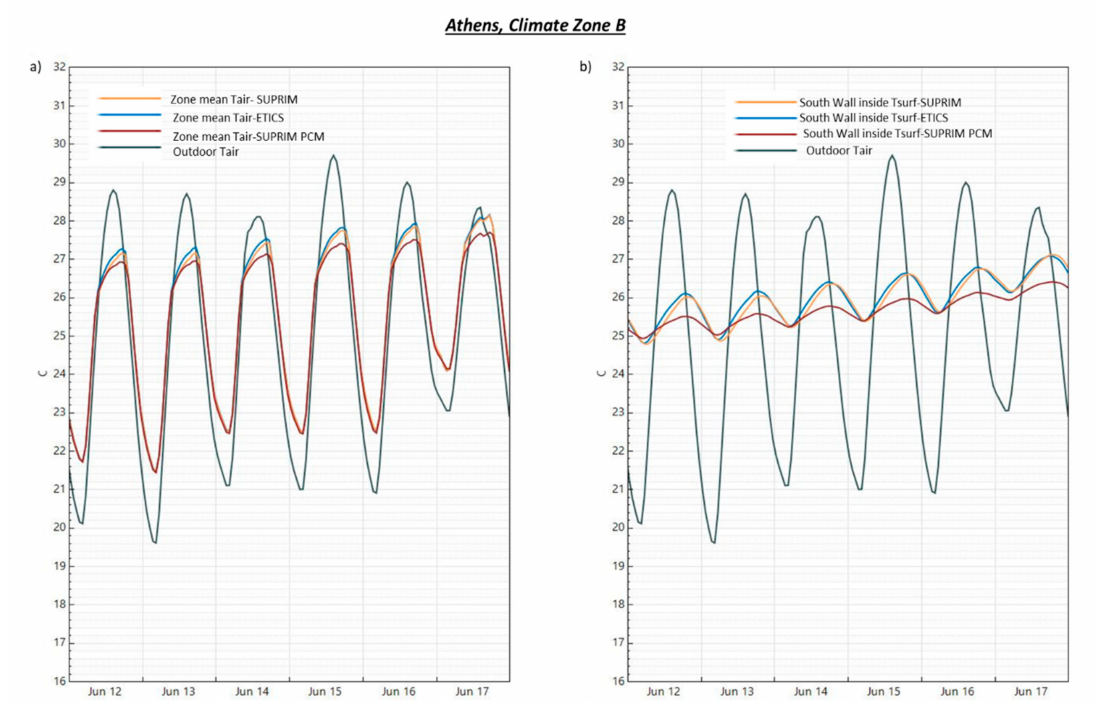
Figure 9. Climate zone B: ( a ) outdoor Tair and indoor Tair and ( b ) outdoor Tair and Tsurf evolution of the south facing wall during a typical week in June for the three investigated wall configurations and for 10 cm external